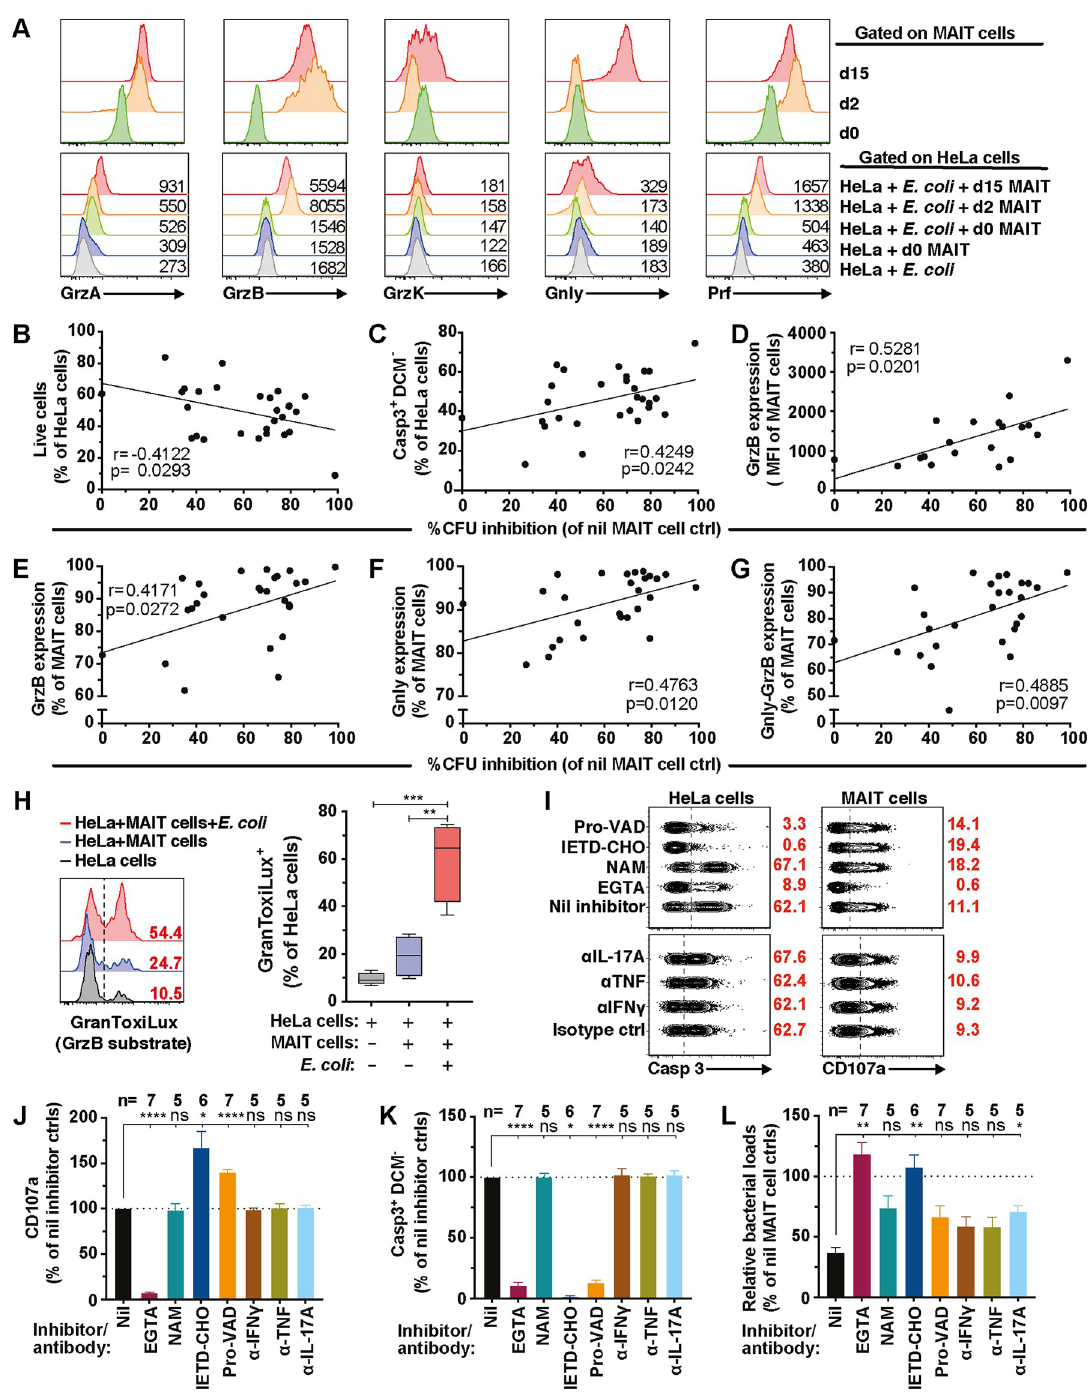
Fig 2. MAIT cell antimicrobial activity is associated with cytolytic protein expression. (A) Detection of cytolytic protein contents in effector MAIT cells and target E . coli EC120S-infected or uninfected HeLa cells following 3 h co-culture with MAIT cells obtained at different days following MAIT cell activation. Representative histograms from 4 independent donors are shown. (B) Correlation between live ( n = 28) and (C) apoptotic ( n = 28) EC120S-infected HeLa cells, (D) GrzB intensity ( n = 19), (E) GrzB expression ( n = 28), (F) Gnly expression ( n = 27), and (G) Gnly-GrzB co-expression ( n = 27) in MAIT cells with the inhibition of bacterial growth. (H) Levels of the GrzB substrate GranToxiLux activity in uninfected or EC120S-infected HeLa cells with or without MAIT cells ( n = 4). (I) Flow cytometry plots of (J) degranulation by MAIT cells, (K) apoptosis in EC120S-infected HeLa cells, and (L) the relative bacterial loads in the presence of the indicated inhibitors or mAbs. Bar graphs with error bars represent the mean and standard error. Box and whisker